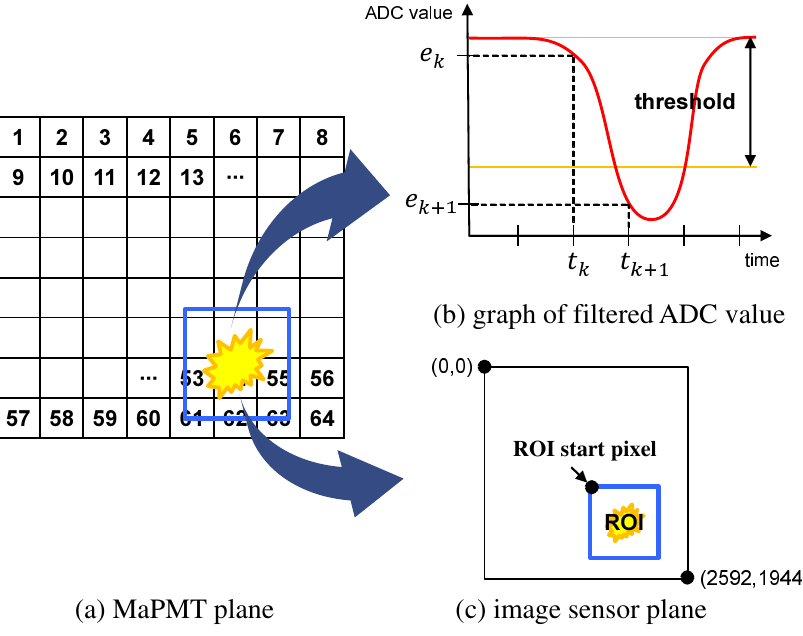
Figure 7. Three discriminators for TLE detection algorithm. ( a ) Potential radiant power by a TLE is assumed to be injected on the 54th cell of the MaPMT. ( b ) Comparison of two consecutive samples of the filtered ADC values by the temporal and energy discriminators confirms that the radiant power is originated from TLE. ( c ) The information from the spatial discriminator is used to set the region of interest (ROI) for the image acquisition